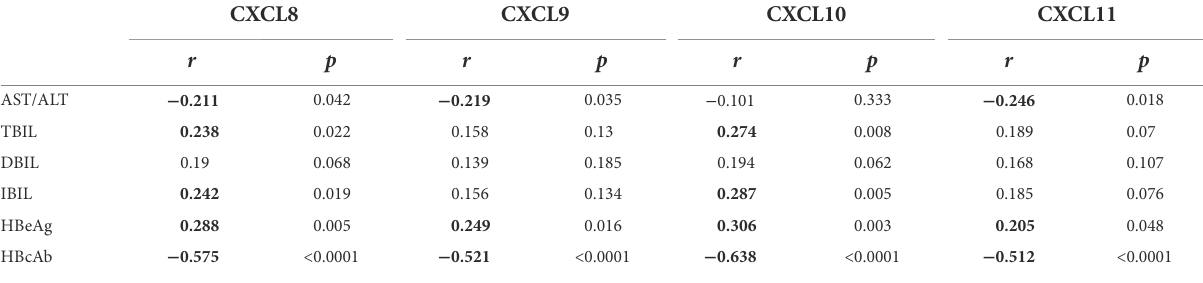
TABLE 3 Correlation analysis of serum chemokines expression levels with biochemical indexes and HBV infection related indexes.